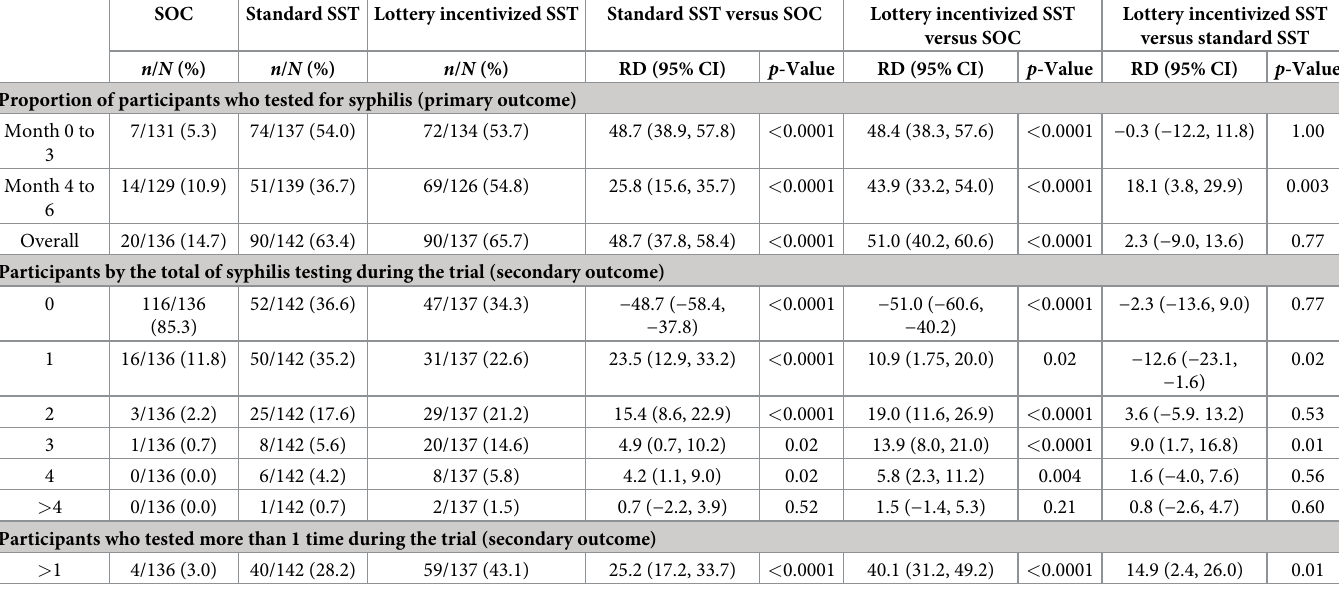
Table 2. Uptake of syphilis testing among participants who initiated at least 1 follow-up survey.